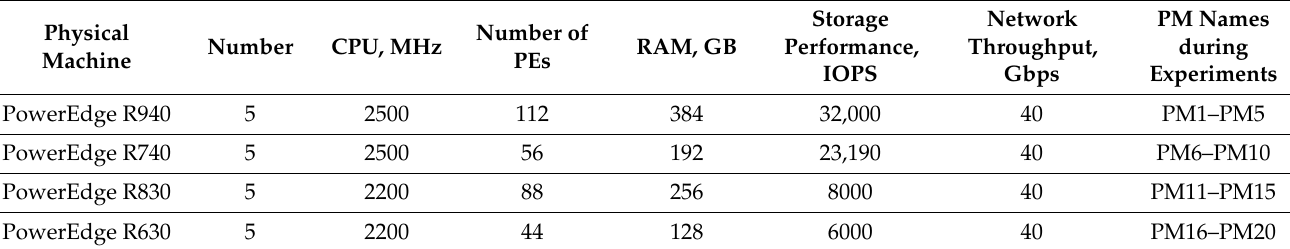
Table 1. Physical machine